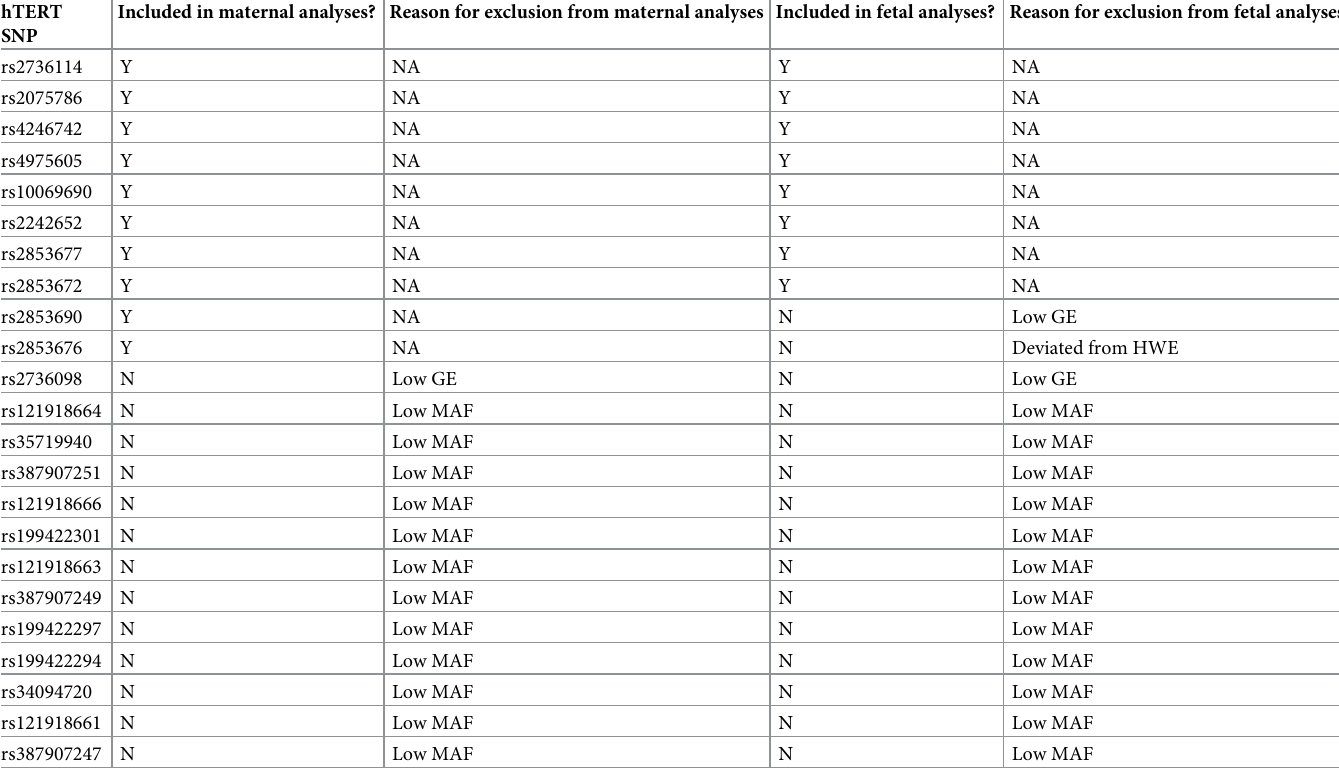
Table 1. hTERT SNPs that were genotyped for maternal and fetal analyses and those that were excluded from analysis. hTERT Included in maternal analyses? Reason for exclusion from maternal analyses Included in fetal analyses? Reason for exclusion from fetal SNP